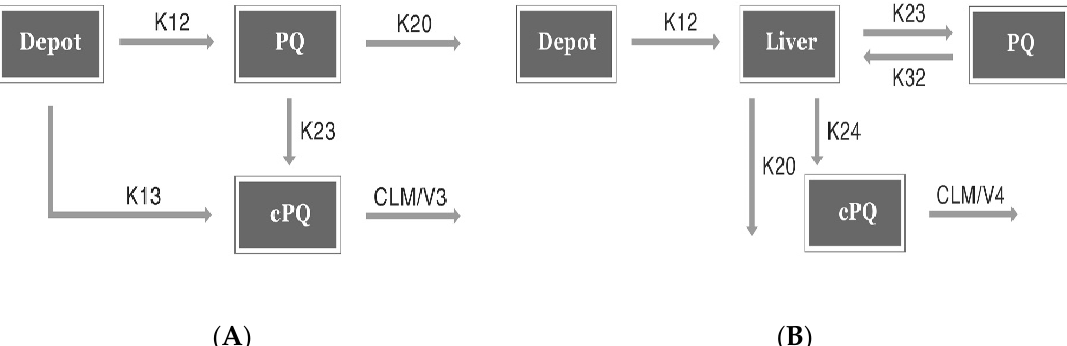
Figure 2. Schematic model. ( A ) Conventional population pharmacokinetics (PPK) model. K12 = (1 − Fa) × KA, K13 = Fa × KA, K23 = FMET × (CL/V2), K20 = (1 − FMET) × (CL/V2), K30 = CLM/V3. PQ, primaquine; CPQ, carboxyprimaquine; KA, absorption rate constant; FMET, fraction of conversion from PQ to CPQ; Fa, 1st pass effect; CLM, clearance of CPQ; V2, volume of distribution for PQ; V3, volume of distribution for CPQ; ( B ) Minimal physiology-based PK (PBPK) model. K12 = KA, K23 = QH × (1 − EH)/V2, K32 = QH/V3, K24 = CL MAO /V2, K20 = CL CYP /V2, K40 = CLM/V4. PQ, primaquine; CPQ, carboxyprimaquine; KA, absorption rate constant; CL CYP , clearance of PQ via CYP2D6 pathway; CL MAO , clearance of PQ via MAO (monoamine oxidase) pathway; CLM, clearance of CPQ; EH, hepatic extraction ratio; QH, liver blood flow; V2, liver volume; V3, volume of distribution for PQ; V4, volume of distribution for CPQ. ‘Depot’ denotes the absorption